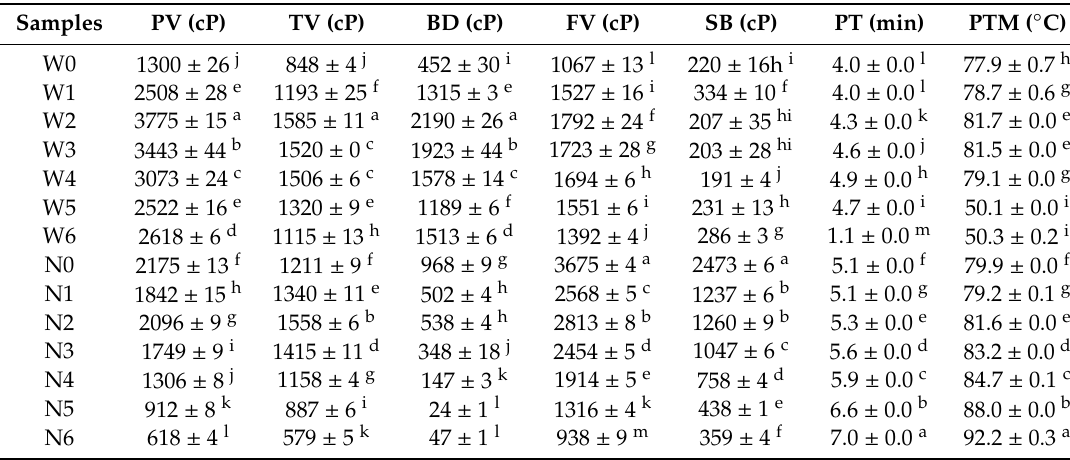
Table 3. Pasting properties of uncooked and cooked